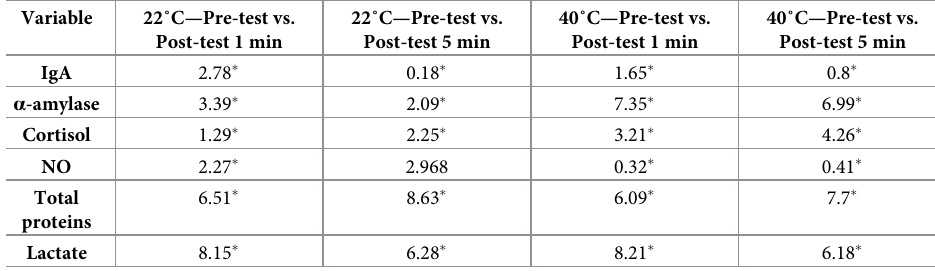
Table 3. Cohen’s d regarding blood variables.